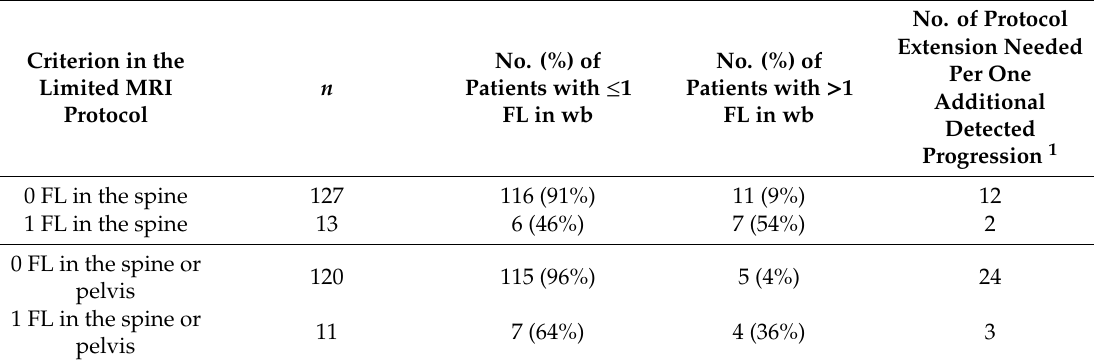
Table 3. Correlation between findings in the limited MRI protocol and presence of > 1 focal lesion (FL) in wb-MRI.